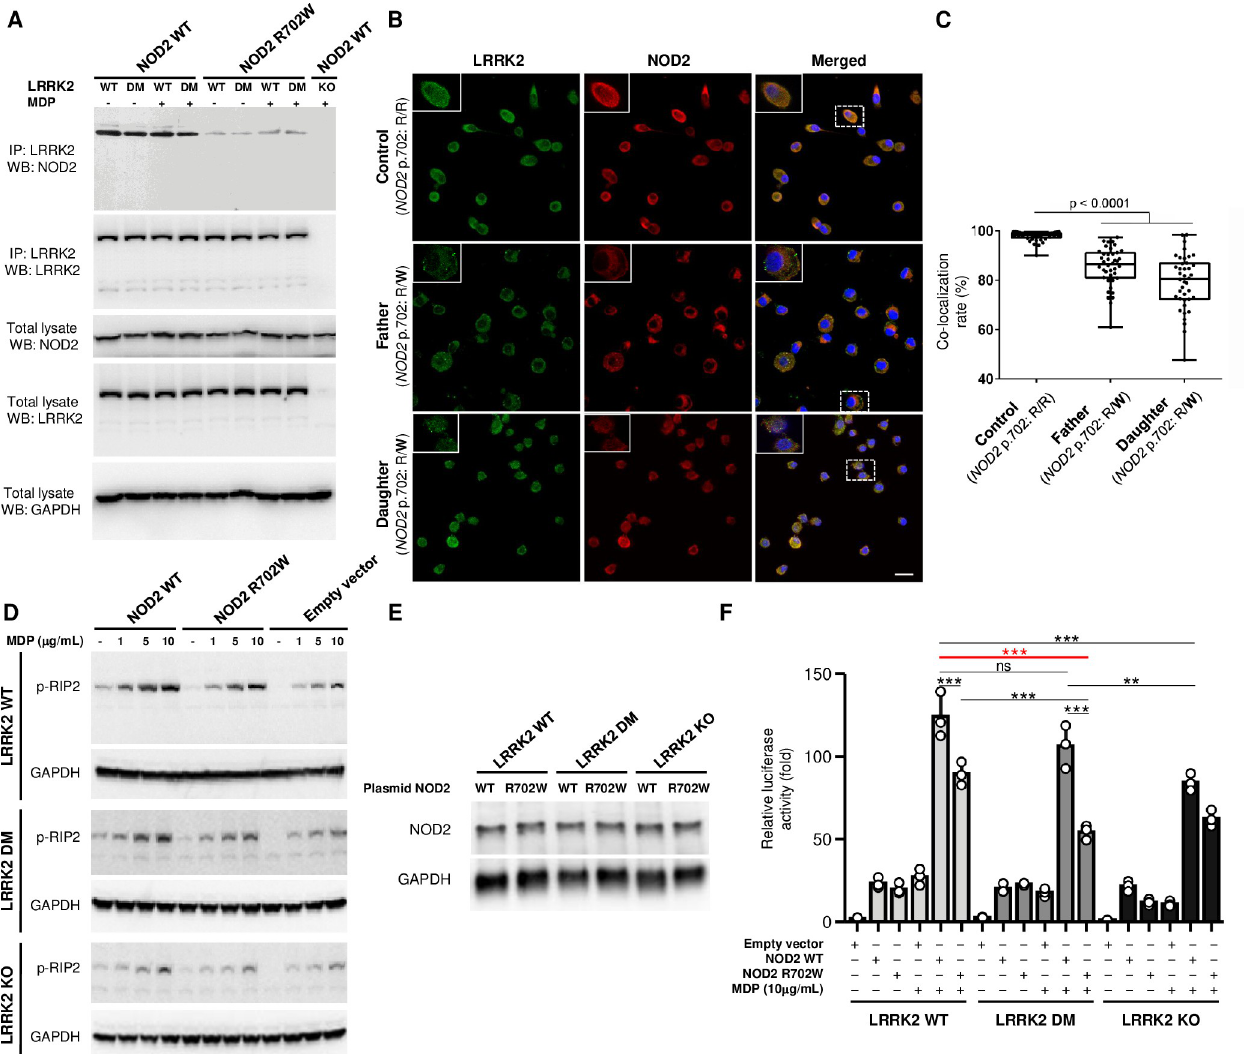
Fig 4. Effects of LRRK2 and NOD2 variants on LRRK2-NOD2 interaction, NOD2-dependent RIP2 phosphorylation and NF- κ B activity. (A) Protein- protein interaction between endogenous LRRK2 and transfected NOD2 by Co-immunoprecipitation (Co-IP). Twenty-four hours post-transfection, cells were left untreated or treated with N-glycolyl MDP (10 μ g/ml) for another 24 hours. Cell lysates were prepared and immunoprecipitated with a rabbit monoclonal antibody against LRRK2. Immunoprecipitants were analyzed by Western blot analysis with antibodies directed against LRRK2 and the FLAG tag of the fused FLAG-NOD2. The expression of LRRK2 and NOD2 using the same antibodies was also analyzed in the total lysate, where GAPDH expression was used as a loading control. LRRK2 KO RAW264.7 cell line transfected with a plasmid expressing NOD2 WT was used as a negative control. ( B-C) Representative confocal images of LRRK2 and NOD2 co-localization in monocyte-derived macrophages. (B) Co-localization of LRRK2 (green) and NOD2 (red) was identified (yellow, merged) in macrophages of two family members (father and twin) with heterozygosity (R/W) for NOD2 p.702 and a control subject with homozygosity (R/R) for the common reference allele. Nuclei were stained with DAPI (blue). Scale bar represents 20 μ m in the figures and 10 μ m in the insets. ( C ) Quantification of total co-localization between LRRK2 and NOD2 was estimated from 40 cells by LAS X Software (Leica). Significance was calculated using one-way ANOVA, comparing each condition with the control using the Kruskal-Wallis test. Each dot represents a cell, the band in the box plot indicates the median, the box indicates the first and third quartiles and the whiskers indicate ± 1.5 × interquartile range. (D) Effects of NOD2 mutation on MDP-induced phosphorylation of RIP2 at Ser 176 in cells with different LRRK2 genotypes. Twenty-four hours post-transfection, cells were left untreated or treated with different concentrations of MDP for another 24 hours. Phosphorylation of RIP2 (p-RIP2) was analyzed by immunoblotting with a specific antibody against phosphorylated at Ser 176 of RIP2. (E) NOD2 expression in the cells from panel D. The displayed results are representative of three independent experiments. The expression of GAPDH is shown as a loading control. ( F ) Effects of LRRK2 and NOD2 variants on NF- κ B activity. The three RAW264.7 cell lines with different LRRK2 genotypes were transfected with NOD2 plasmid (WT, R702W or empty vector) together with NF- κ B firefly-Luc plasmid and Renilla-Luc plasmid pRL-TK (internal control). Twenty-four hours after electroporation, cells were left untreated or treated with 10 μ g/ml of N- glycolyl MDP for another 24 hours. Cell lysates were subjected to luciferase assays. Results are expressed as relative luciferase activity (fold change), as compared with the luciferase activity of LRRK2 KO cells transfected with empty vector in the absence of N-glycolyl MDP. Results are presented as mean ± SD of a representative experiment (done in triplicate) of three independent experiments. Significance of difference between LRRK2 WT+NOD2 WT